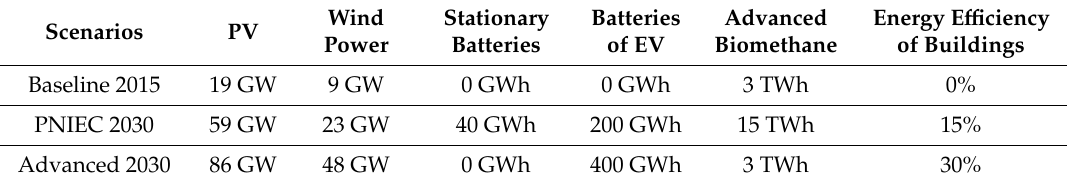
Table 4. Values of the main technologies in the di ff erent